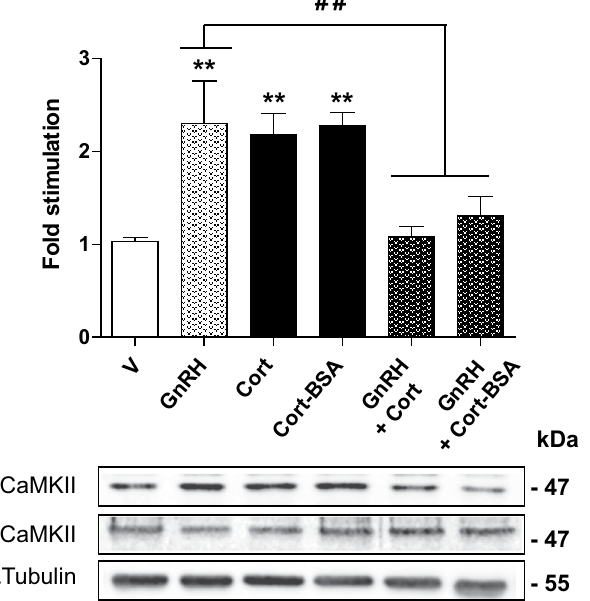
Figure 4. GC prevent GnRH-induced CaMKII phosphorylation. L β T2 cells were treated or not (V) with GnRH (10 − 8 M), Cort (10 − 7 M), Cort-BSA (10 − 7 M) or co-treated with either GnRH and Cort or GnRH and Cort-BSA for 5 min. Cell lysates were subjected to WB with anti-CaMKII, anti-p-CaMKII, and anti- α -tubulin antibodies. Cropped blots (full length WBs are presented in Supplementary Fig. S4e) are shown in the figure and are representative of 3 independent experiments. Results are expressed as means ± SEM fold stimulation when compared to vehicle. One-way ANOVA with Dunnett’s post-test, ** p < 0.01. ## p < 0.01 comparing GnRH with both